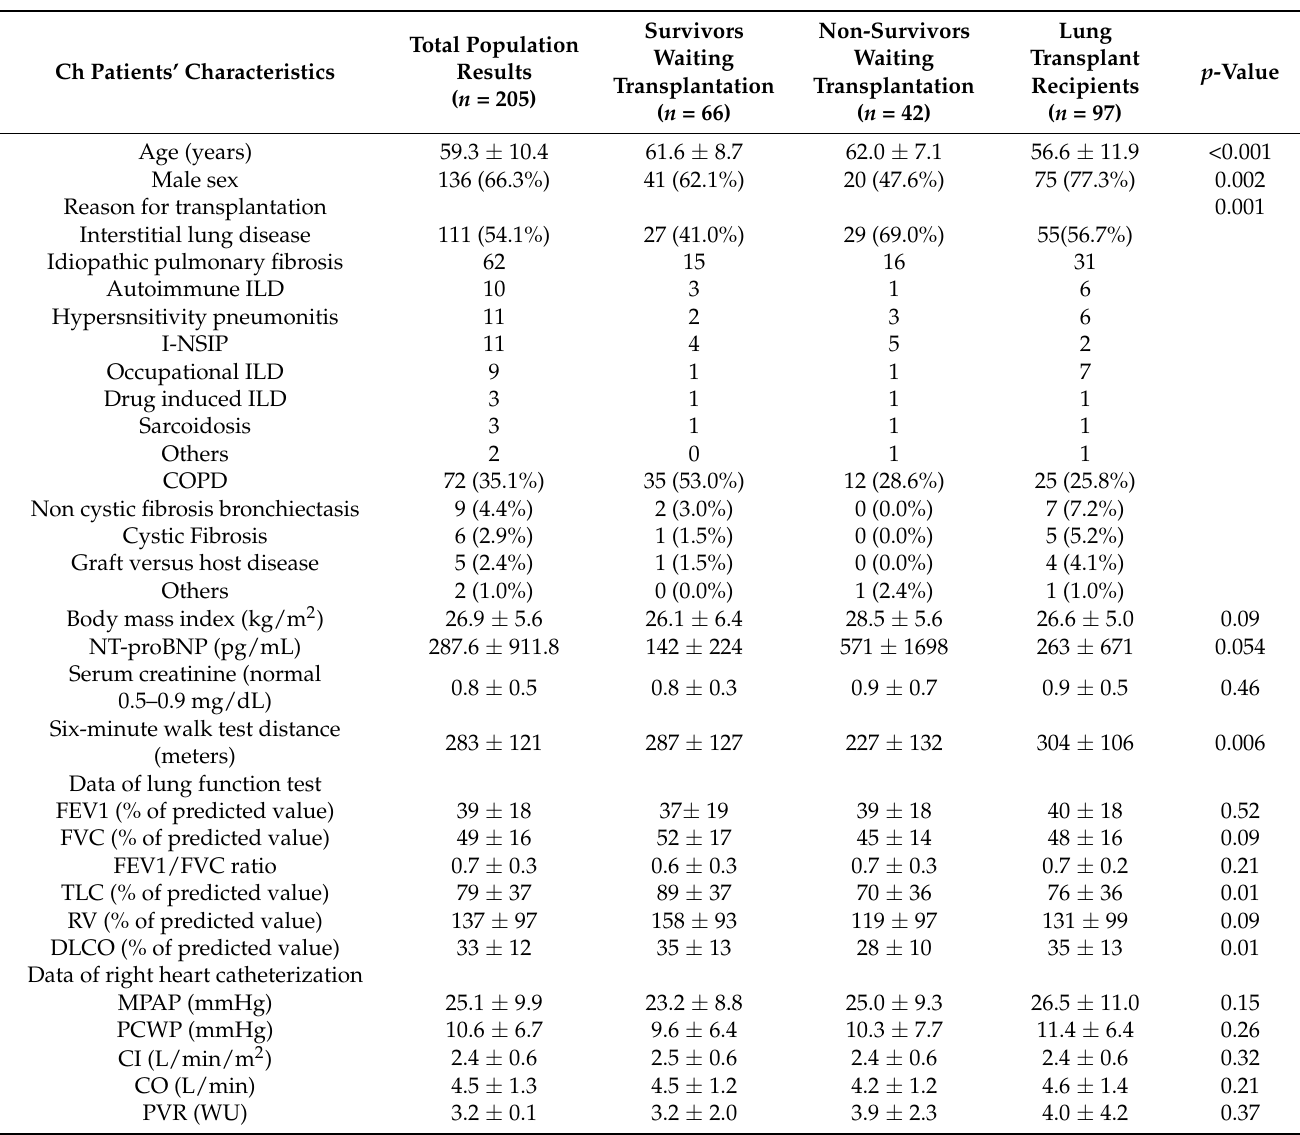
Table 1. Baseline characteristics of waitlisted lung transplant candidates stratified according to receipt of transplantation, and survival or death while waiting for the